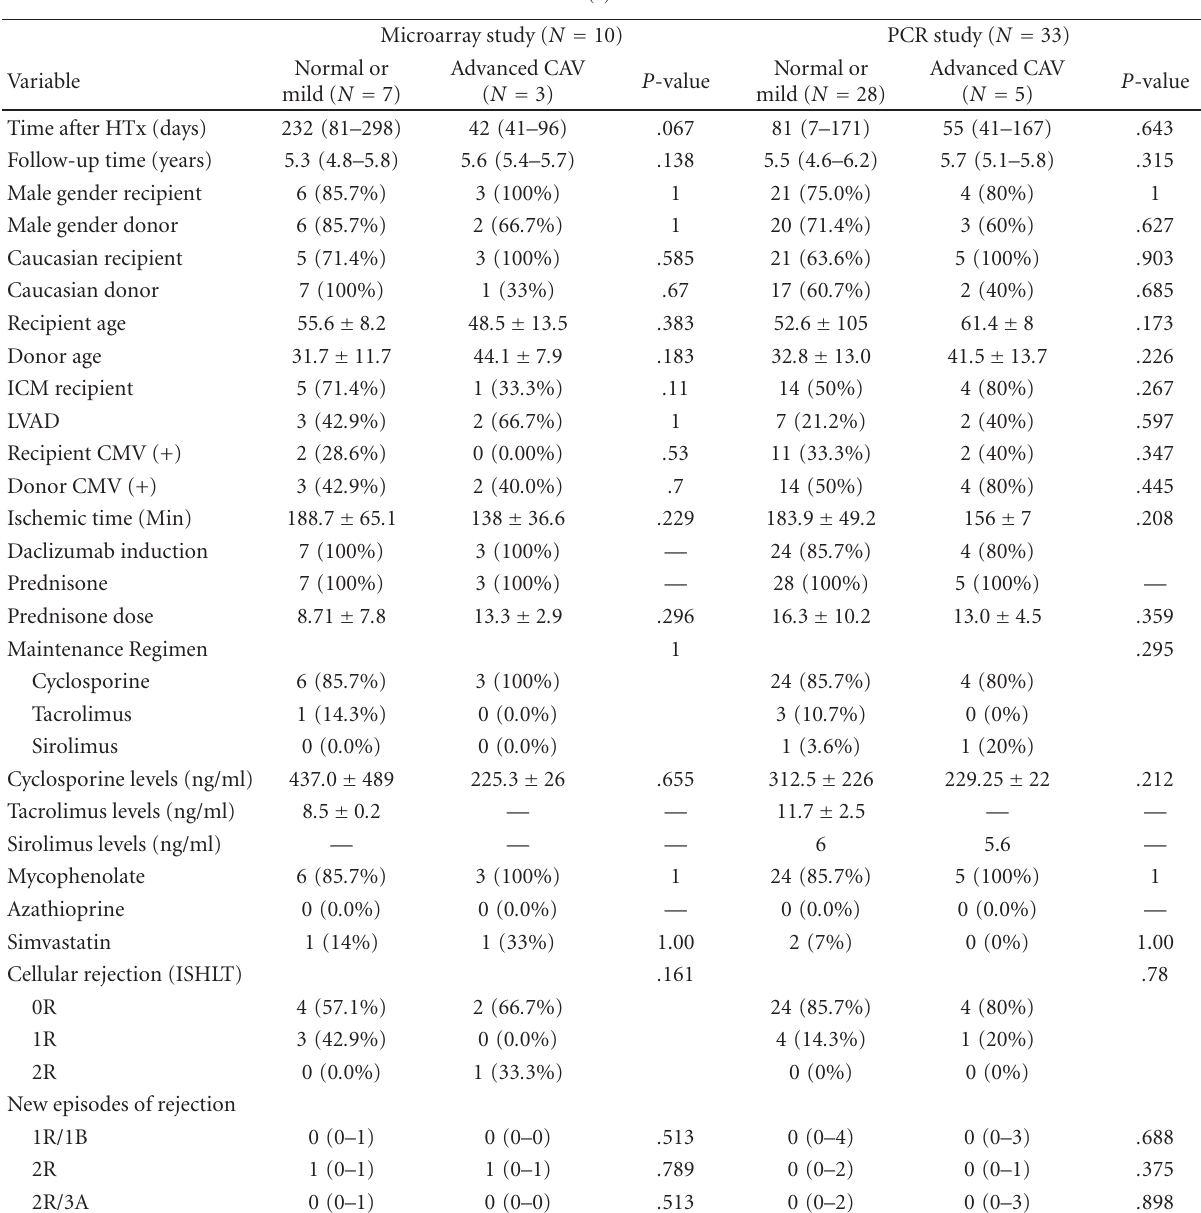
Table 1: Baseline clinical characteristics. Baseline Clinical Characteristics Comparing Microarray and PCR Study